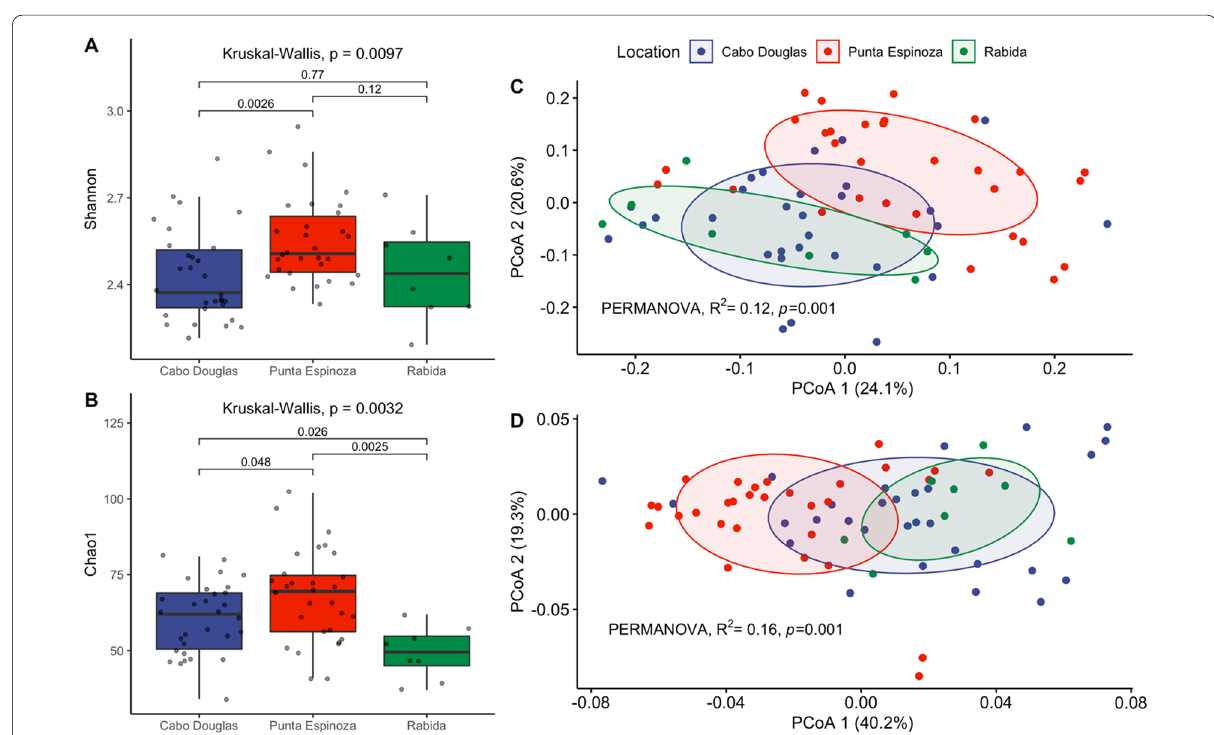
Fig. 2 Microbiome alpha and beta diversity from 16 s rRNA sequences. Alpha diversity was measured with Shannon ( A ) and Chao1 ( B ) indexes. Wilcoxon test was used to compare the values between locations. Beta diversity was calculated with Bray-Curtis dissimilarity matrix ( C ) and Weighted Unifrac ( D ), which were examined with Principal Coordinate Analysis (PCoA). The ellipses in C and D contain at least 70% of the samples per location